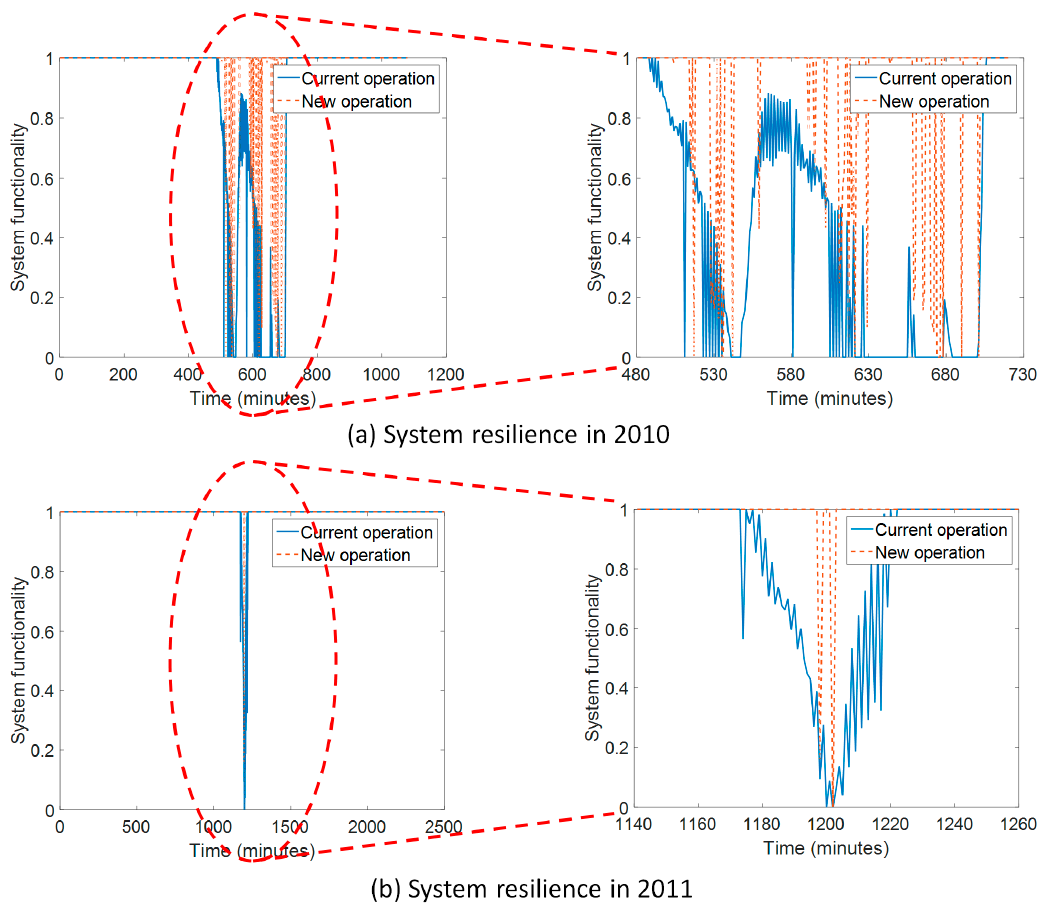
Figure 13. System resilience for the current and new operations in ( a ) 2010 and ( b ) 2011.